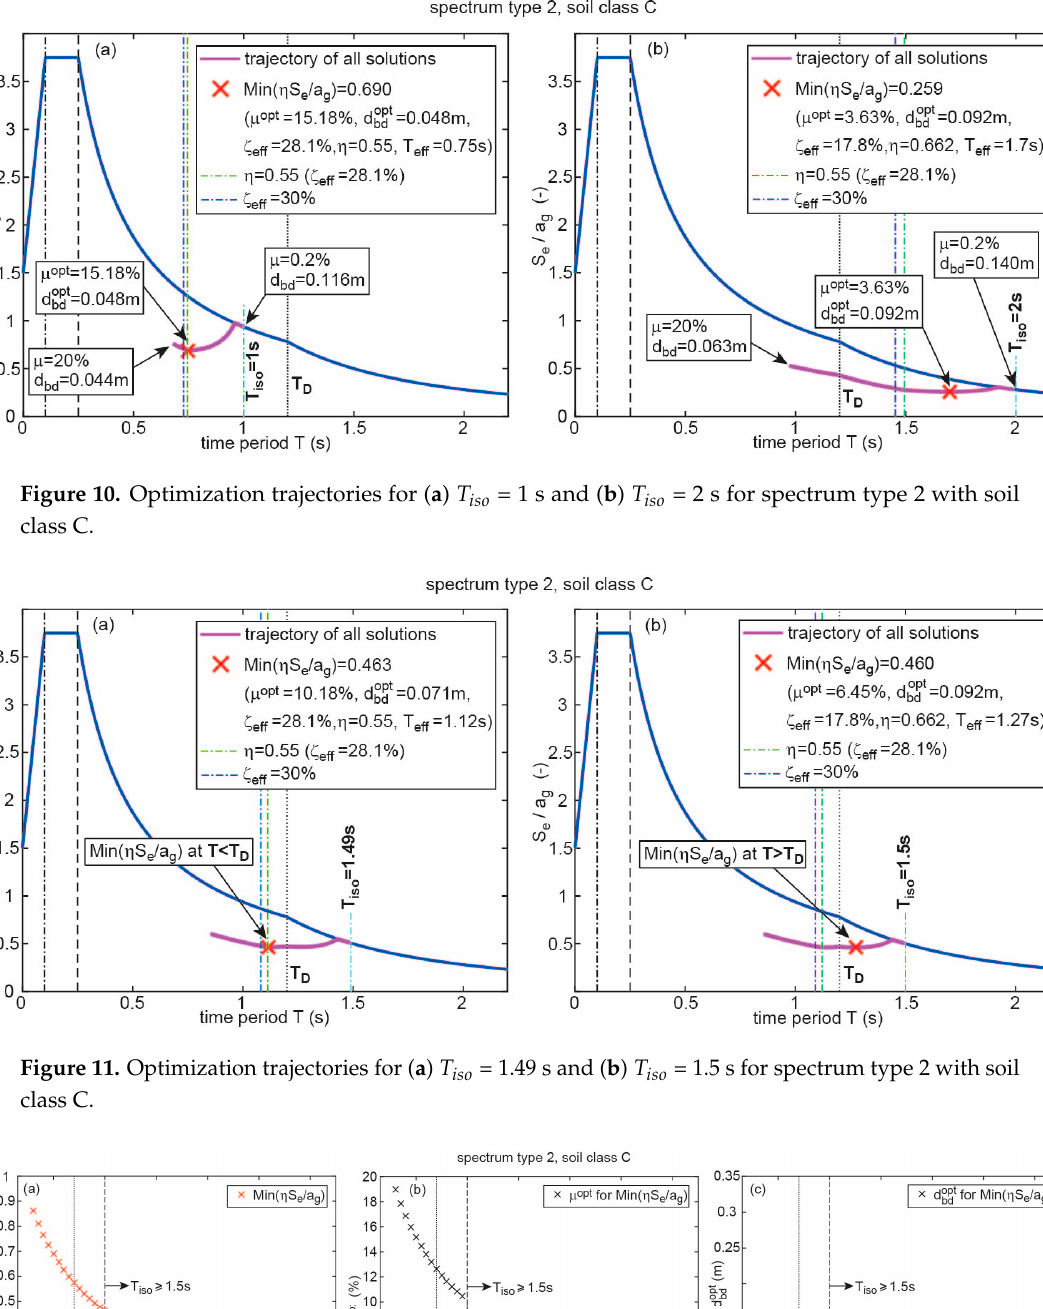
Figure 12. ( a ) Minimum structural acceleration due to optimum selections of ( b ) friction coefficient and ( c ) displacement capacity for spectrum type 2 with soil class C.